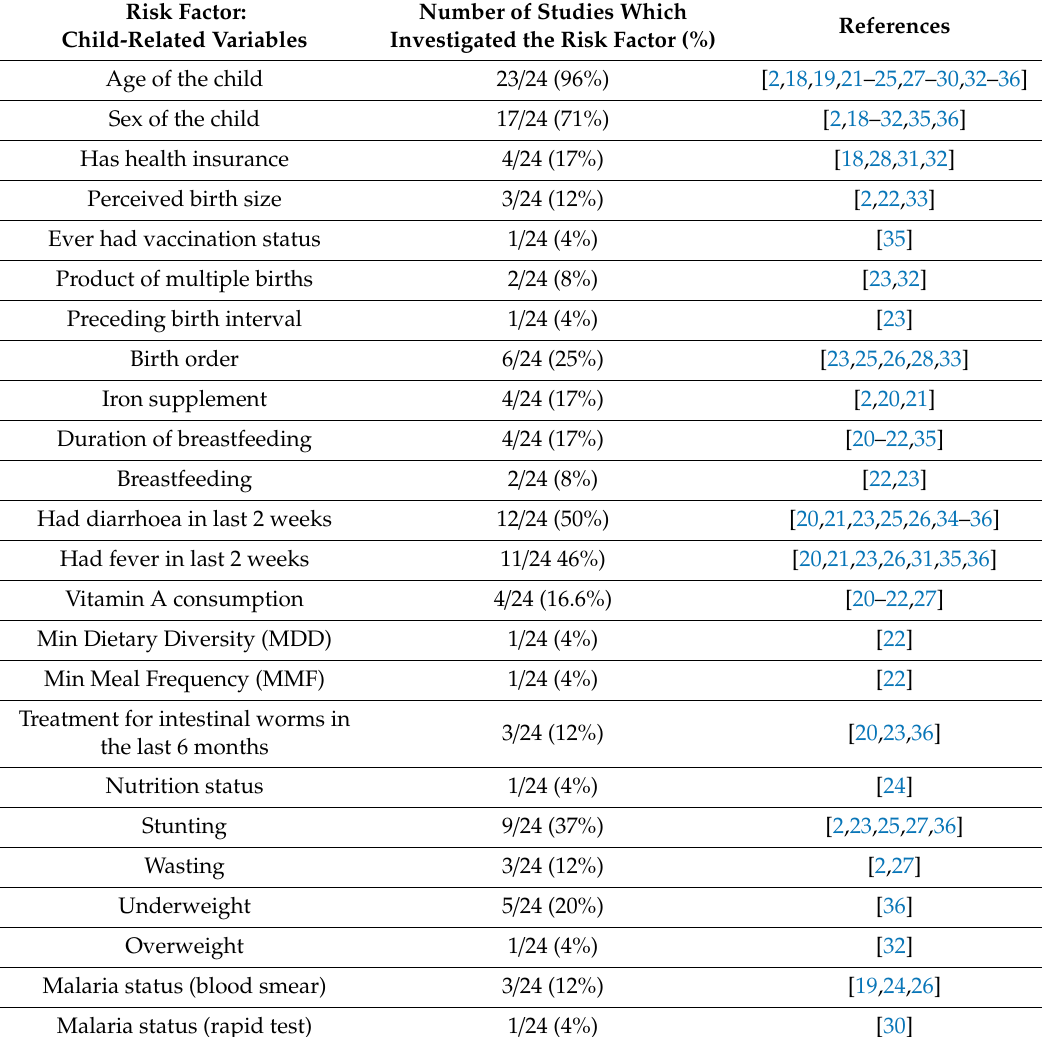
Table 5. Distribution of the child-related variables for anaemia from the 24 country-specific